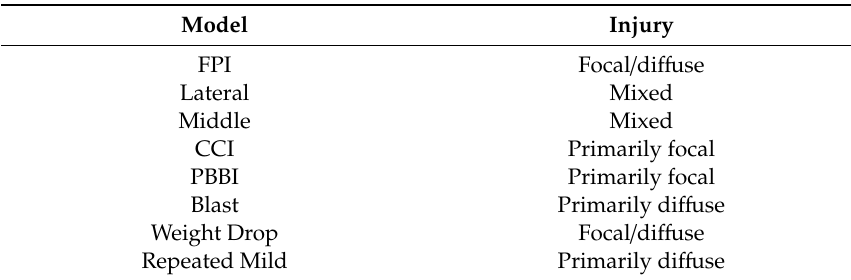
Table 1. Animal models of traumatic brain injury